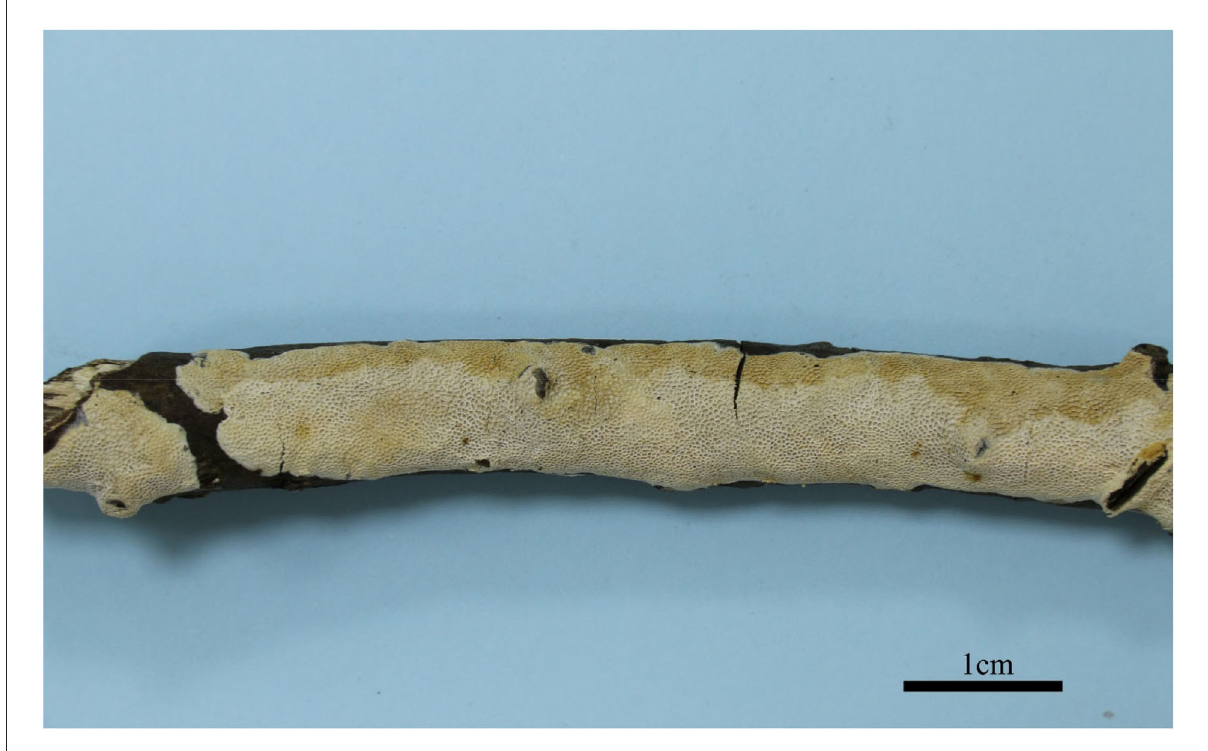
FIGURE2 Basidiocarps of Jorgewrightia austroasiana (holotype, Dai